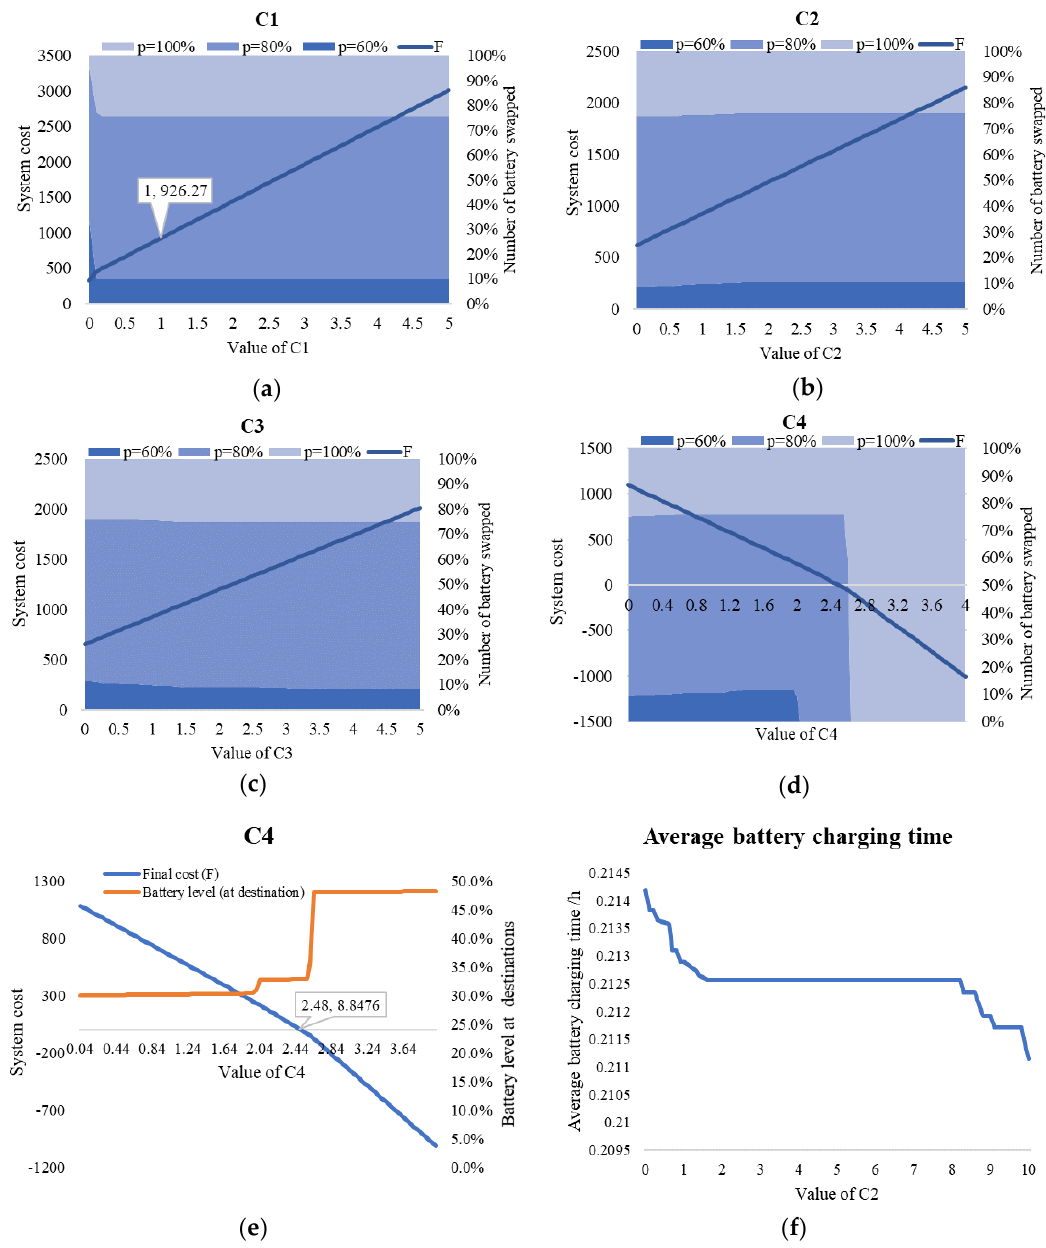
Figure 8. System operational cost performance and number of batteries swapped with varying values of ( a ) C 1 ; ( b ) C 2 ; ( c ) C 3 ; and ( d ) C 4 . ( e ) Average battery charging time with varying C 2 . ( f ) System operational cost performance and battery level at the destination with varying C 4 .